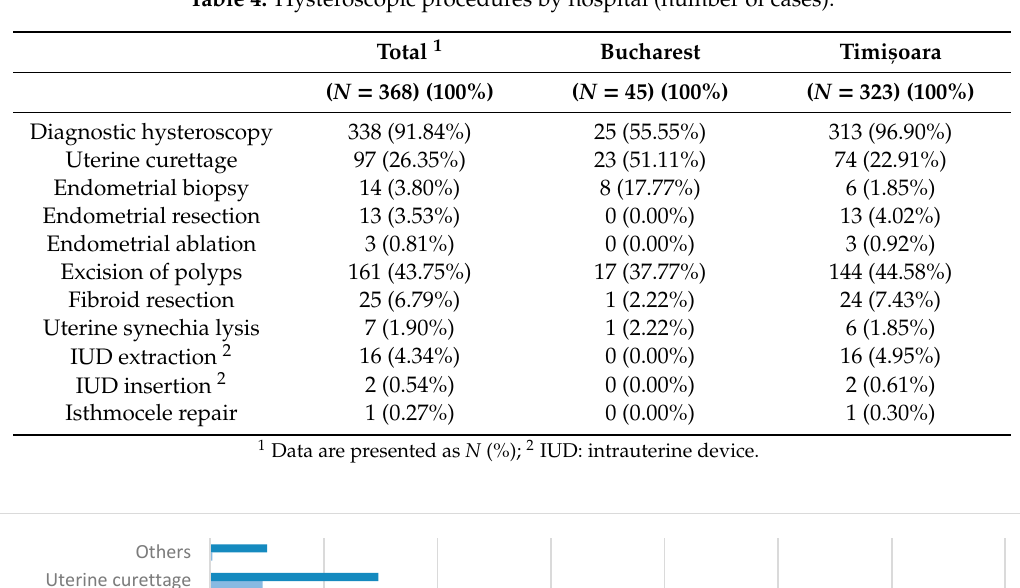
Table 4. Hysteroscopic procedures by hospital (number of cases).